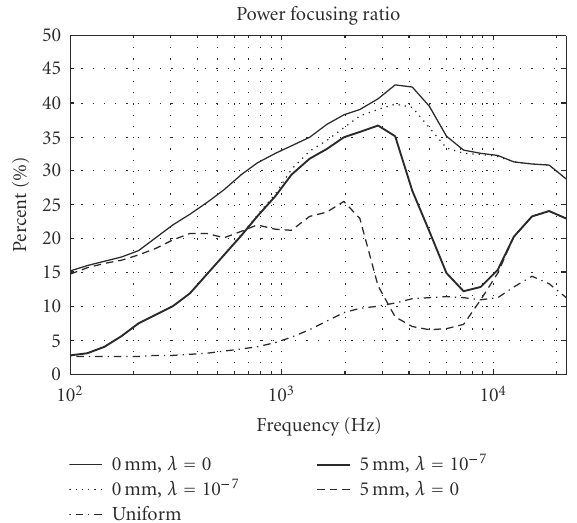
Figure 8: Influence of position errors on the power focusing ratio (PFR), with or without regularization. The position errors are uni- formly distributed between [ − 2 . 5,2 .